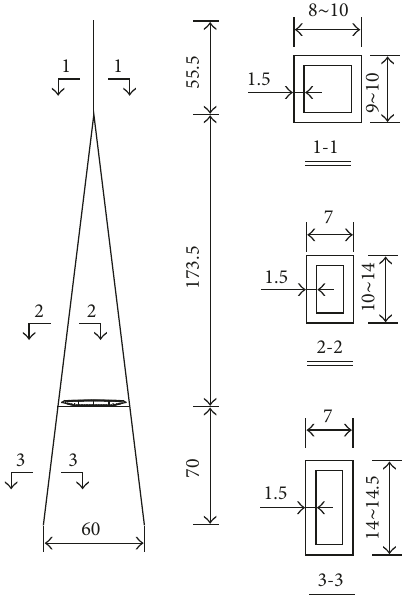
Figure 3: Layout of the pylon (unit: m).